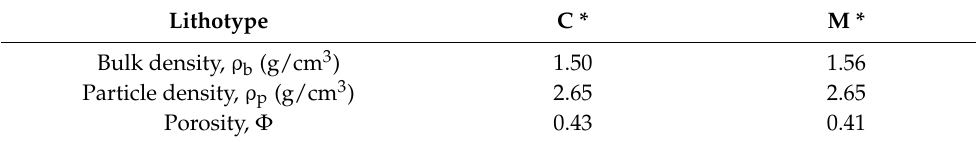
Table 1. Physical properties of rock lithotypes.